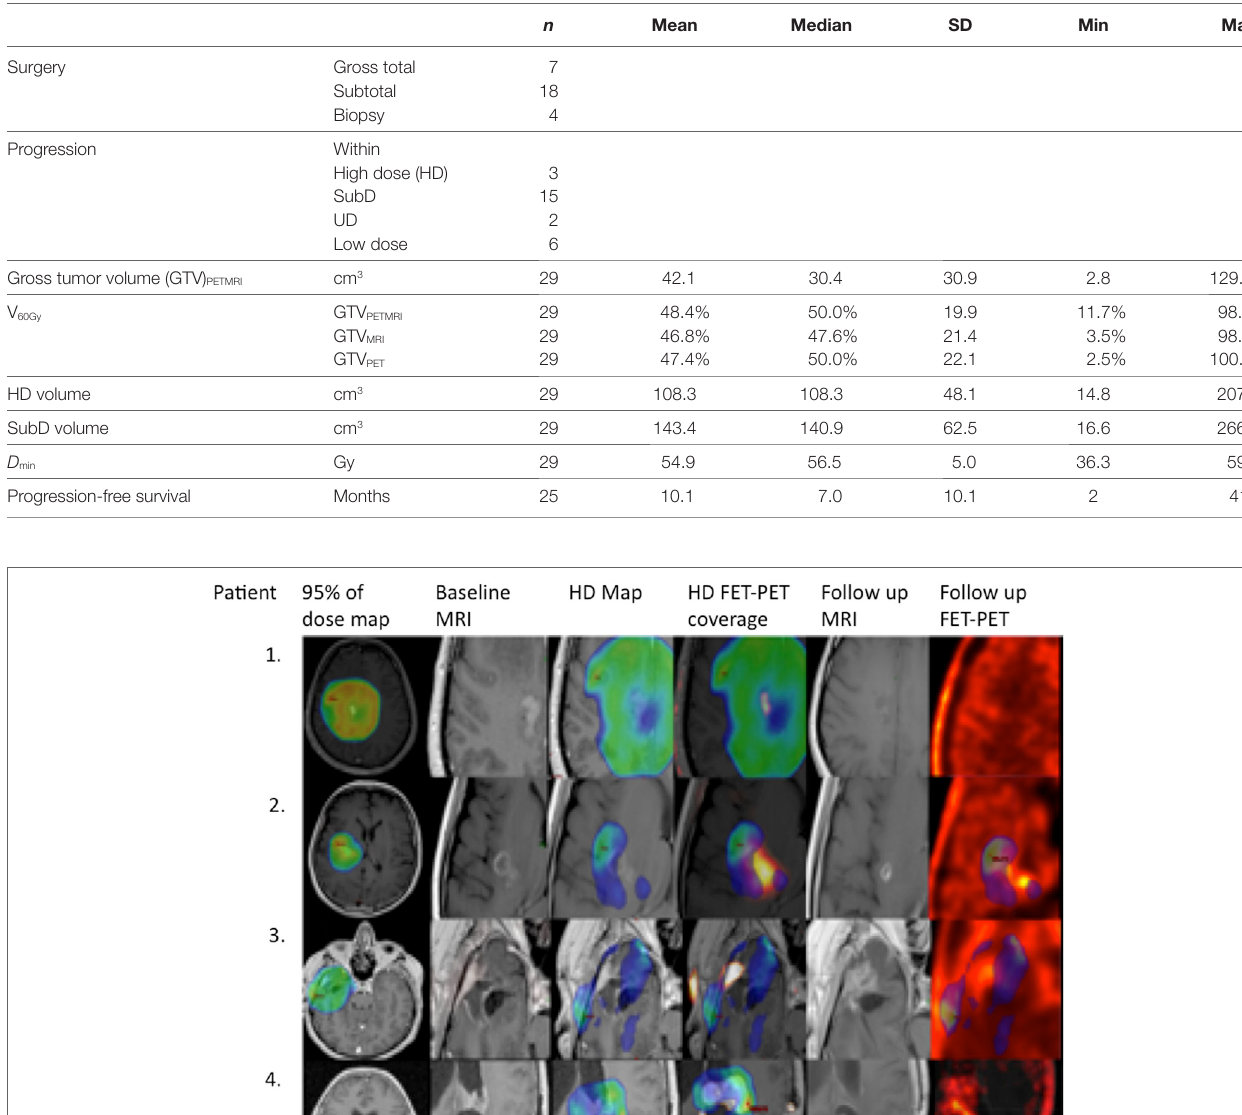
Table 1 | Summary of patient data (volumes in cubic